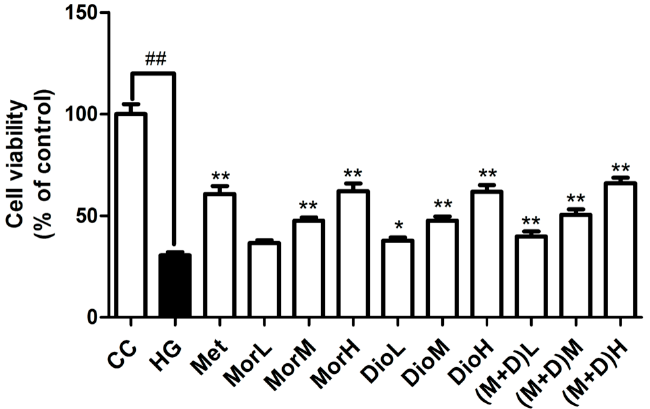
Figure 1. Effects of Mor (25, 50, 100 µ g/mL), Dio (25, 50, 100 µ g/mL), and M + D (25, 50, 100 µ g/mL) on rat cardiomyocyte viability under HG-induced cell injury after pretreated 72 h. Values are expressed as